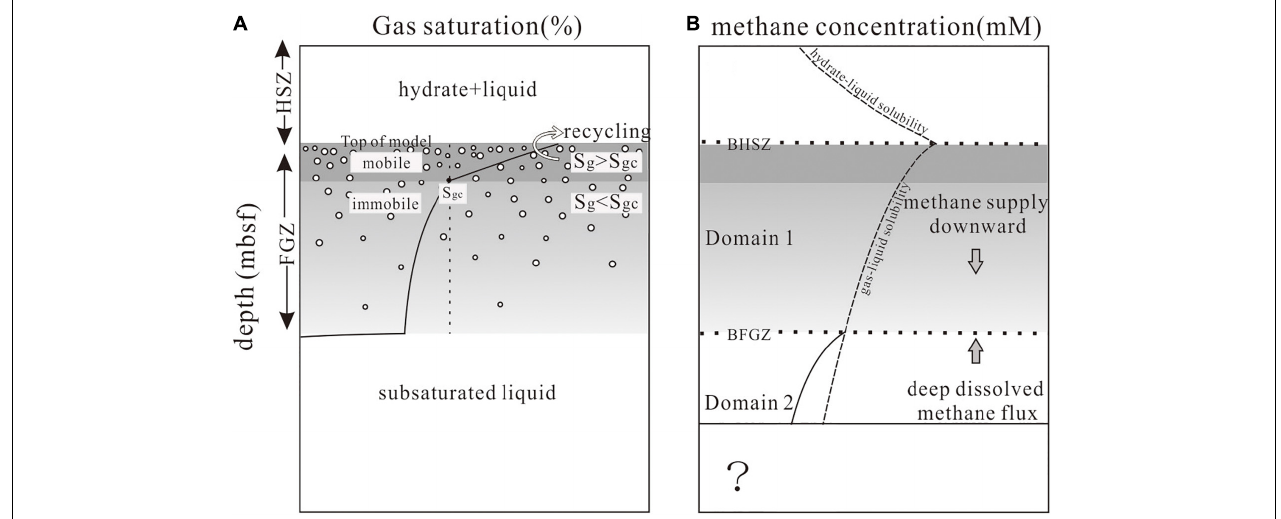
FIGURE 1 | Conceptual illustration of the free gas system below the BHSZ. (A) The region below the top of model (BHSZ) is divided into two domains. The mobile free gas shown in shaded dark gray was produced through hydrate dissociation, accumulated at the BHSZ or moved upward due to the buoyancy and left a certain gas which equals to the residual gas saturation (S gc ). These mobile gas bubbles occupy an extremely thin layer compared with the large gas distribution zone that controlled by the sedimentation and shown in shaded light gray. This model neglects the upward gas bubbles. (B) Dotted lines represent the BHSZ and BFGZ. Dashed lines represent hydrate-liquid and gas-liquid solubility curves. The downward gaseous methane and diffused methane and the upward flow of unsaturated fluid collectively affect the amount of methane in pore water, which results in inter-conversion between the gaseous methane and dissolved methane. The gas bubbles no longer exist below the BFGZ because gaseous methane at the BFGZ compensates the deep unsaturated dissolved methane. The methane concentration profile represented by black solid line in Domain 2 is plotted according to the deep methane flux. The question mark represents the possibility of the gas bubble occurrence beneath Domain 2 since the gas-liquid solubility tends to decrease with depth. The gas bubbles would exist if the methane concentration exceeds the gas-liquid solubility.